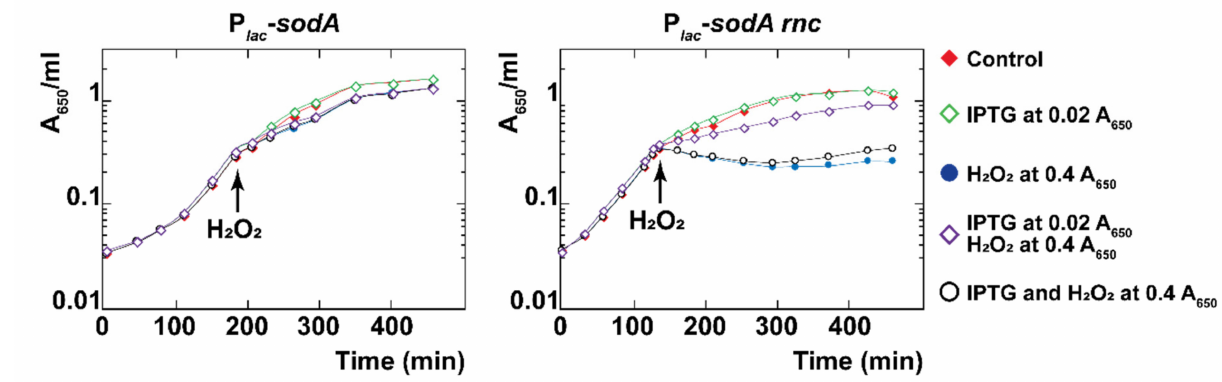
Figure 7. Ectopic expression of sodA protects from oxidative stress in the rnc mutant. N3433 P lac - sodA and IBPC633 P lac -sodA strains containing the pBR lacI q expressing lacI q constitutively were grown to mid-log phase, and IPTG (0.1 mM) and H 2 O 2 (1 mM) were added as indicated. Red filled diamonds show the control with no additions; empty green diamonds show IPTG added at the beginning of the growth; blue filled circles show H 2 O 2 added at mid-log phase; empty purple diamonds show IPTG added at the beginning of the growth and H 2 O 2 at mid-log phase; empty black circles show IPTG added together with H 2 O 2 at mid-log